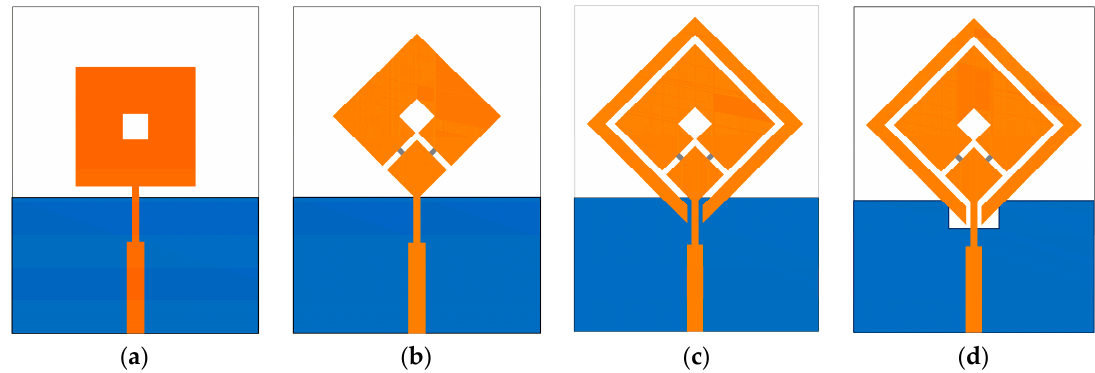
Figure 3. Evolutional procedure for the proposed antenna: ( a ) STEP 1; ( b ) STEP 2; ( c ) STEP 3; ( d ) STEP 4.